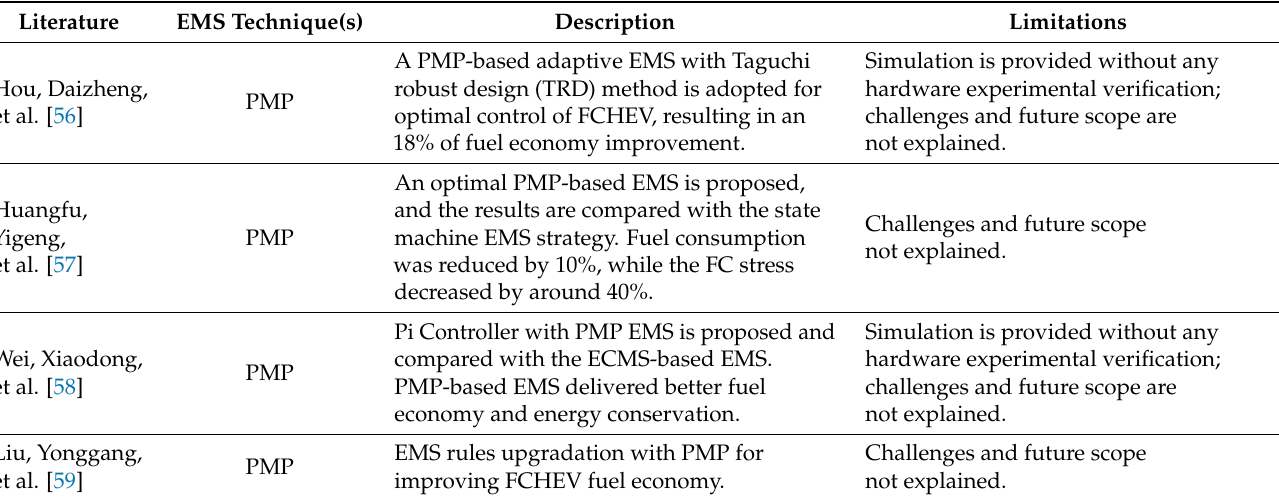
Table 5. Summary of the latest literature related to PMP-based